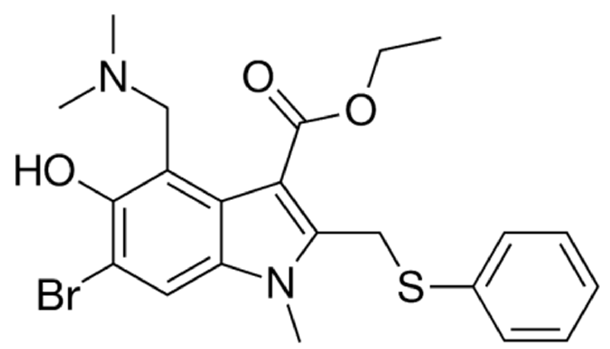
Scheme 1. Molecular structure of Umifenovir